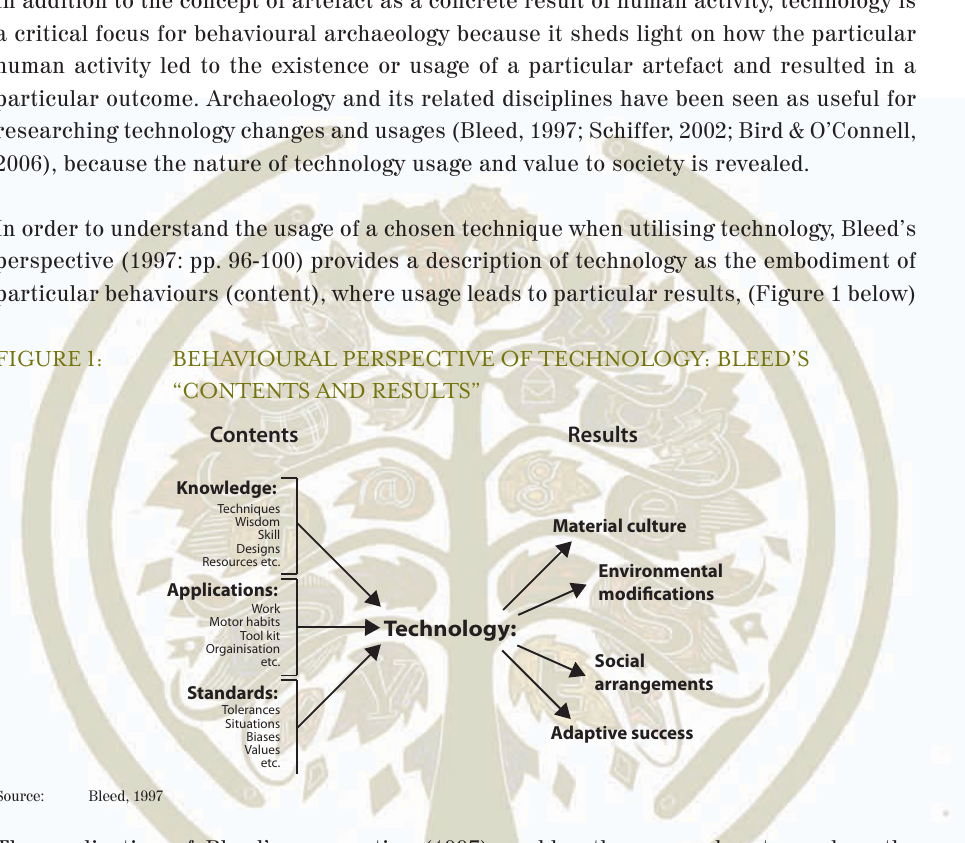
BEHAVIOURAL PERSPECTIVE OF TECHNOLOGY: BLEED’S “CONTENTS AND